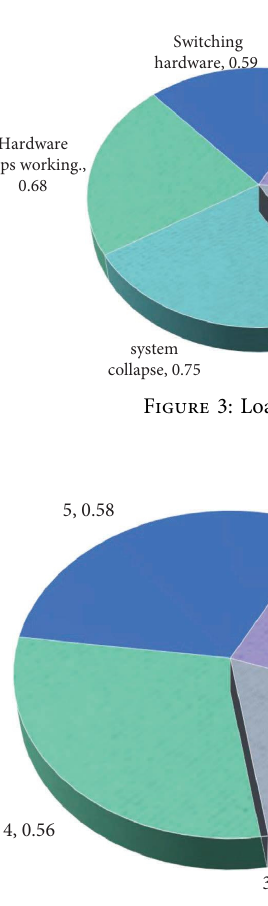
Figure 4: Overload